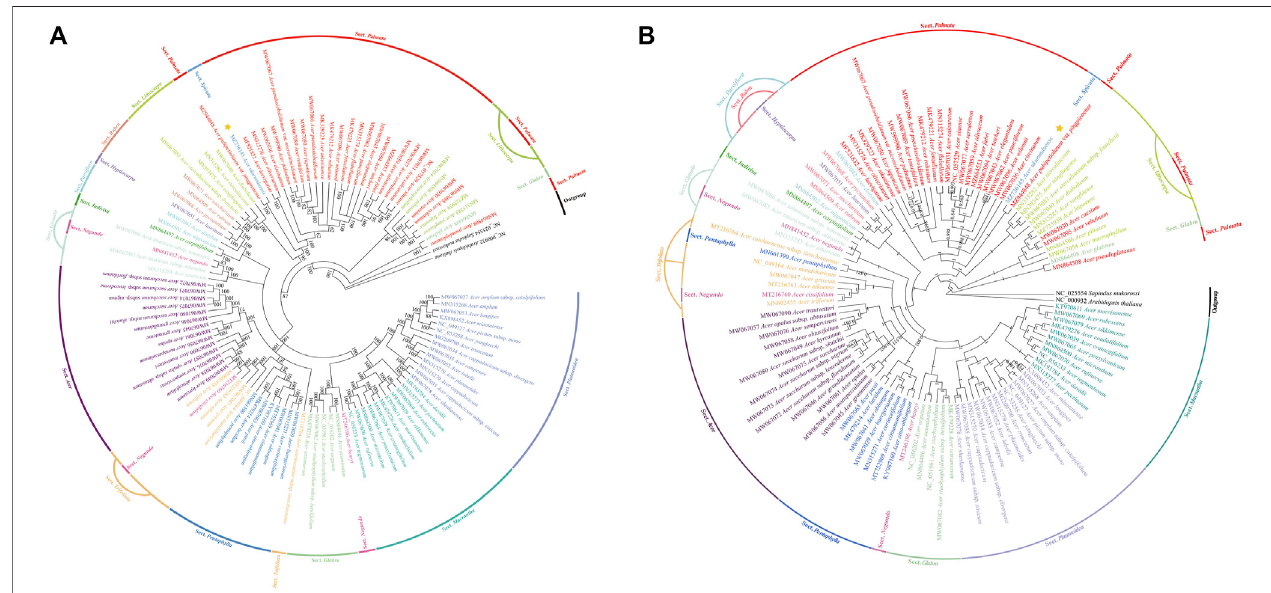
FIGURE 9 | Phylogenetic trees based on 107 species of the whole-cp genome sequences using maximum likelihood (ML) (A) and Bayesian inference (BI) (B) analyses. Numbers at nodes are values for bootstrap support. Sequences from Sapindus mukorossi and Arabidopsis thaliana served as outgroups. The position of A. ukurunduense is indicated by a yellow